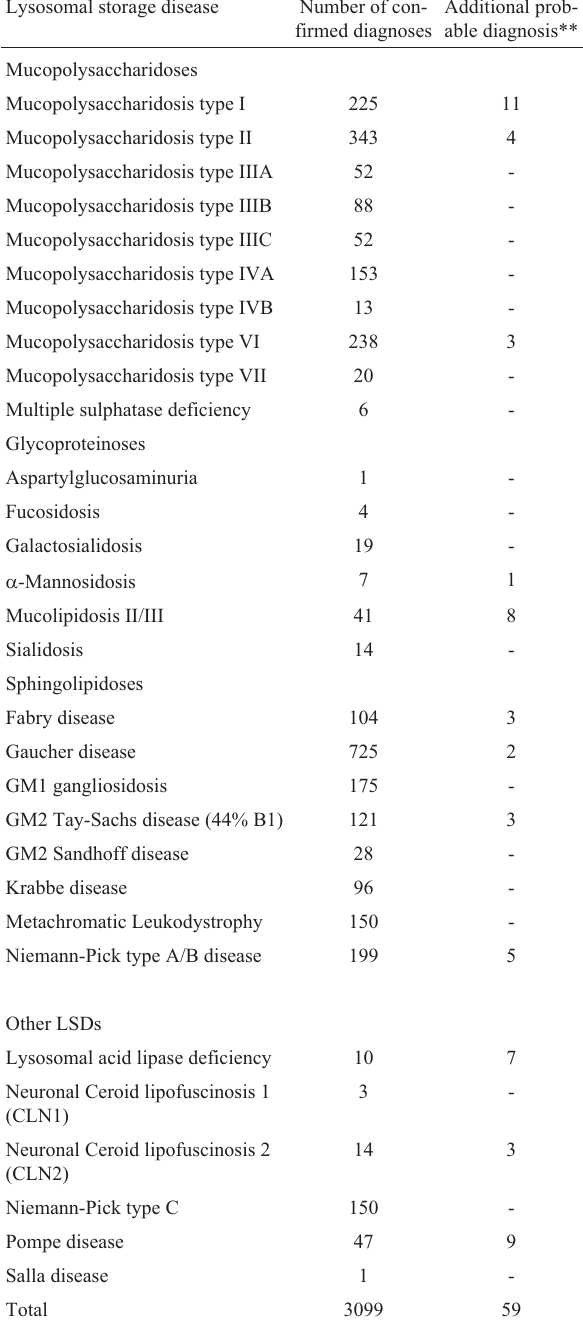
Table 4 - Lysosomal storage diseases diagnosed from 1982 to 2015 in Brazilian patients*. Lysosomal storage